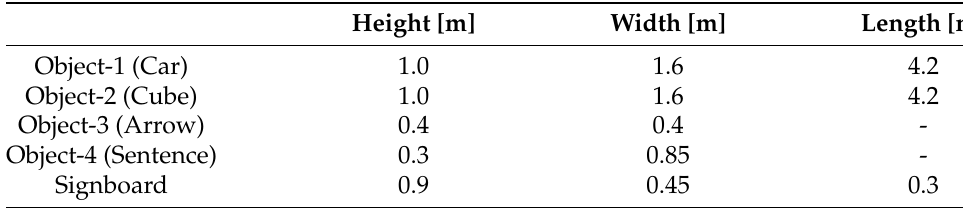
Figure 1. The appearances of placed objects. Table 2. Size of each object.